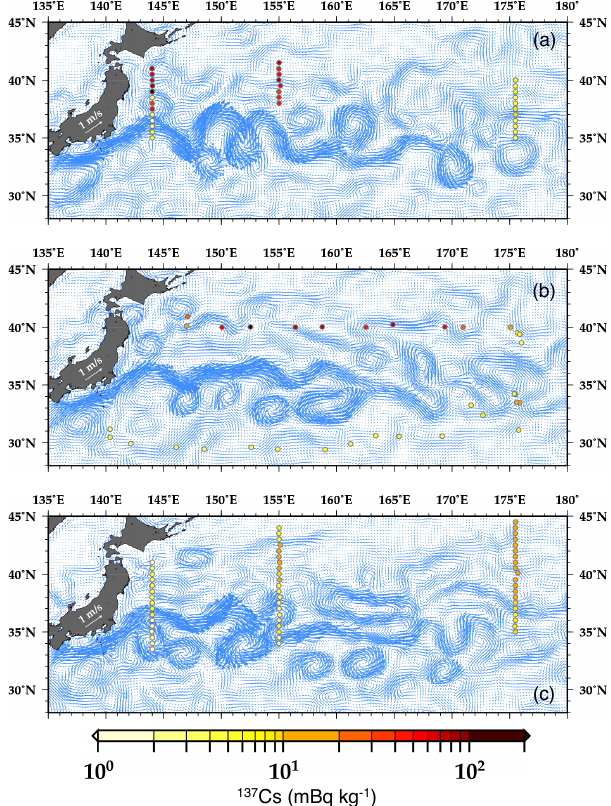
Fig. 1. Sampling locations for surface seawater in the western and central North Pacific. Closed circles indicate the sampling sta- tions. Color of the closed circles indicates concentration of 137 Cs in the surface seawater. Blue arrows indicate the estimated tempo- ral mean velocity vectors for the period between (a) 30 June and 29 July 2011, (b) 14 October and 7 November 2011, and (c) 2 July and 1 August